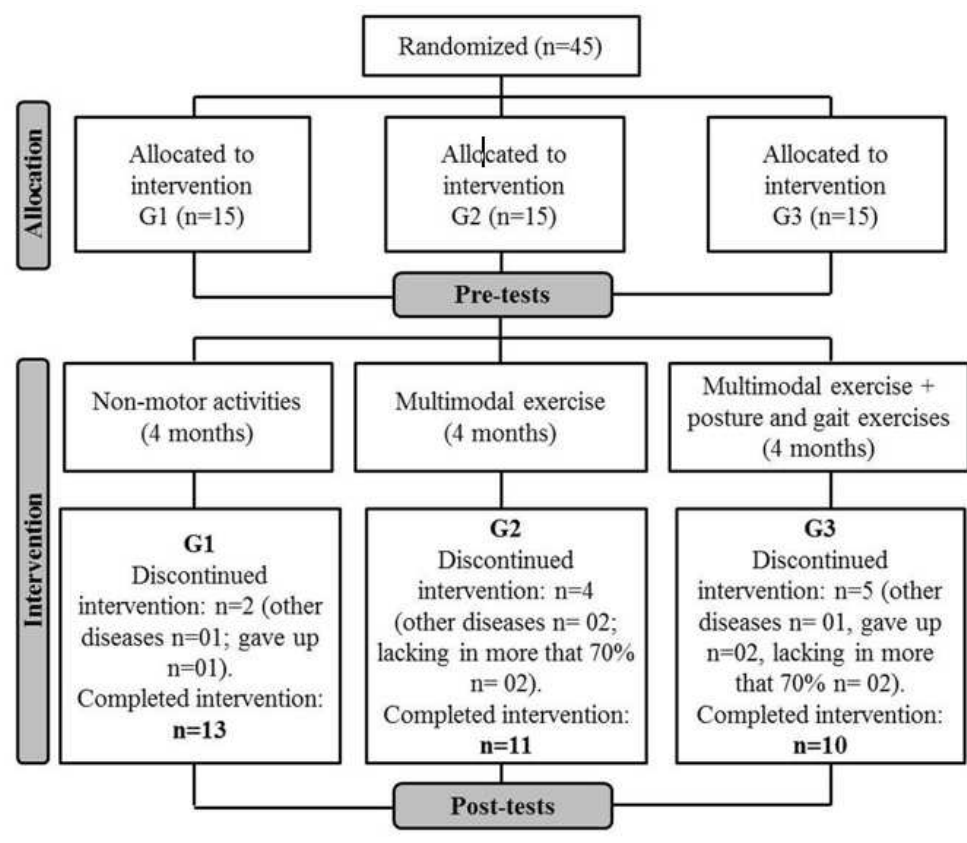
Figure 1. Flow diagram for the 34 individuals who completed the